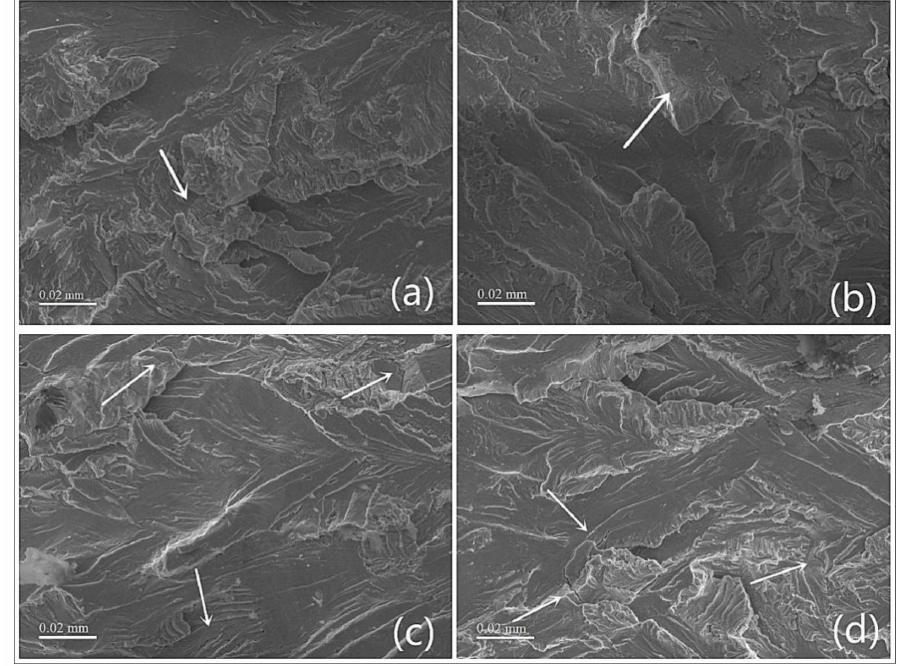
Figure 12. Crack distributions in fatigue propagation zone at di ff erent temperatures: ( a ) 35 ◦ C, ( b ) 40 ◦ C, ( c ) 45 ◦ C, and ( d ) 50 ◦